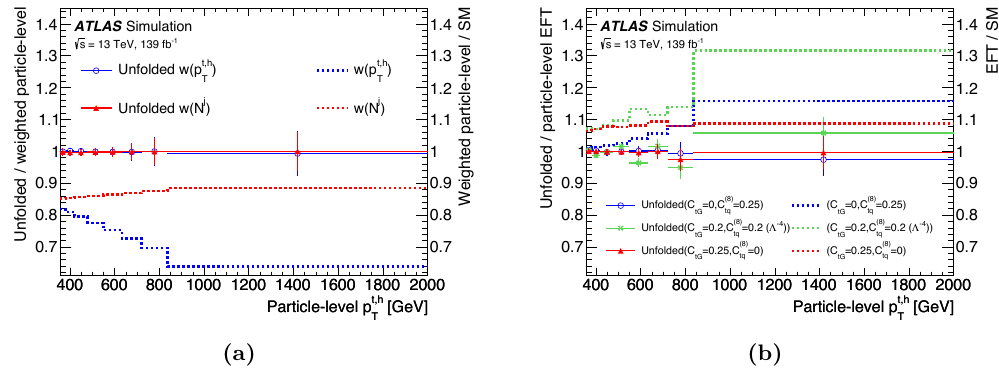
Figure 3. The ratio of unfolded pseudo-data to the corresponding particle-level prediction as a function of p t,h is shown in (a) for pseudo-data built by reweighting the MC sample to match the T data in the p t,h (solid blue) and N j (solid red) distributions. The equivalent ratio is shown in T (b) for pseudo-data built from the nominal MC sample and adding contributions corresponding to = 0 . 25 (blue), C (8) = 0 . 25 (red, including only Λ − 2 contributions) and ( C C tG tq (green, including Λ − 2 and Λ − 4 contributions). The dotted lines show in (a) the ratio of the weighted particle-level distribution to the particle-level distribution from the nominal t ¯ t MC sample and in (b) the ratio of the particle-level distribution of the EFT to the nominal t ¯ t sample. The y -axis on the right of each plot refers to these dotted